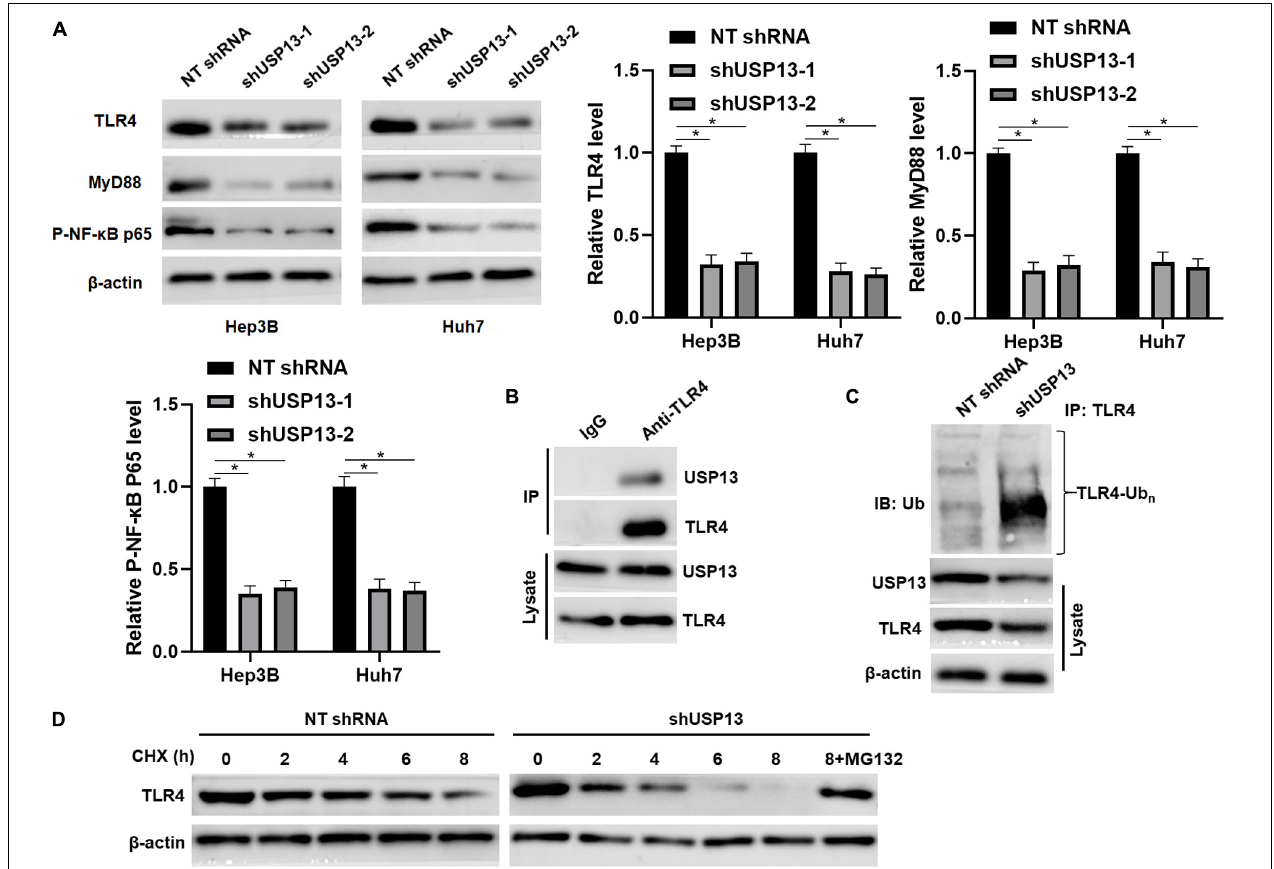
FIGURE 5 | USP13 knockdown reduced the stabilization of TLR4. (A) Hep3B and Huh7 cells were transfected with non-targeting (NT) shRNA and USP13 shRNAs (shUSP13-1 and shUSP13-2), respectively, and detected by WB for TLR4, MyD88, and P-NF- κ B p65 expression. (B) USP13 was immunoprecipitated by TLR4 in Hep3B cells. (C) USP13 silencing increased the ubiquitination of TLR4 in Hep3B cells. (D) Hep3B cells, with or without USP13 knockdown, were treated with CHX (40 mg/ml) to block protein synthesis. WB was performed to detect TLR4 level at different time points. The proteasome inhibitor MG132 (25 µ M) was used to suppress TLR4 degradation. * P <